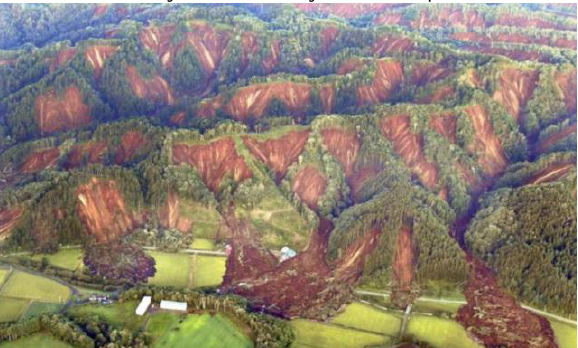
Figure 2. An example to intense landslides after the Hokkaido earthquake on September 6 th , 2018. (Image credit: